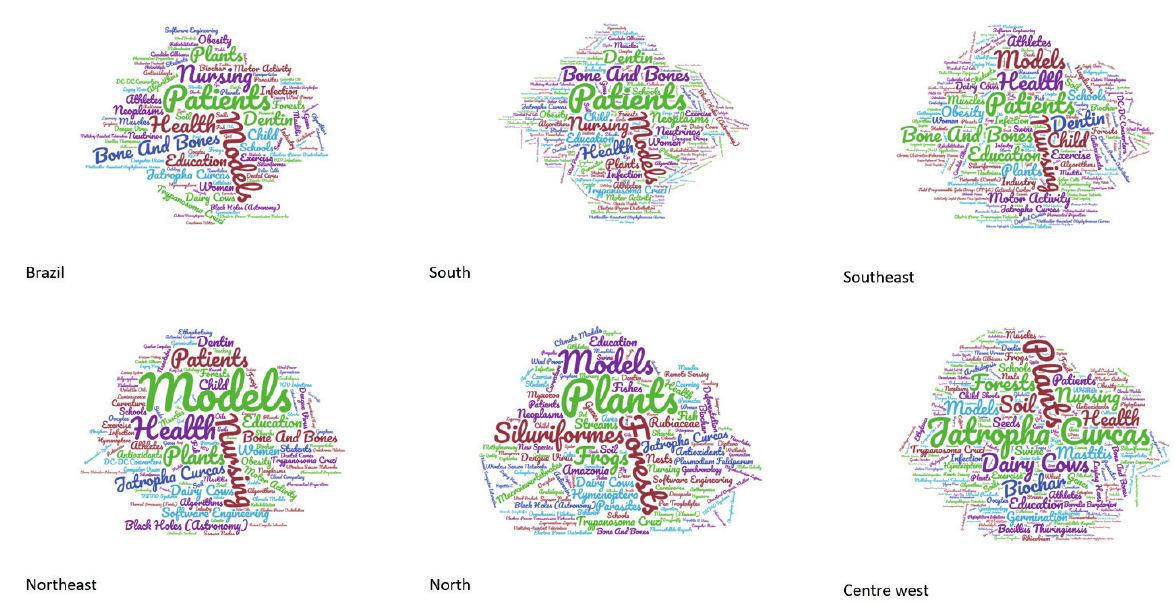
Figure 9. Word Clouds for Major Topics (measured by number of publications in SciVal®) studied in Brazil and by